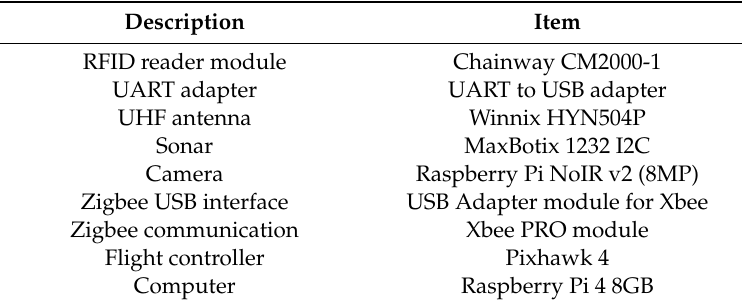
Table 2. UAV test hardware.